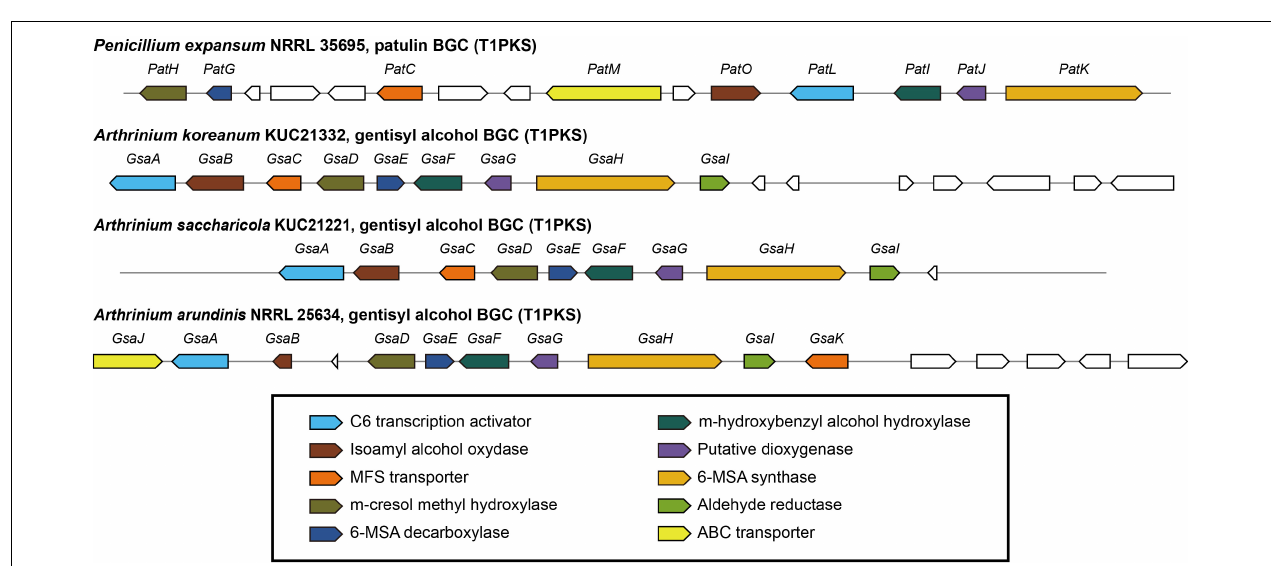
FIGURE 3 | Predicted gentisyl alcohol biosynthetic gene clusters (BGCs) of Arthrinium spp. matched to the patulin BGC of Penicillium expansum . Transcription direction is indicated by arrowheads.